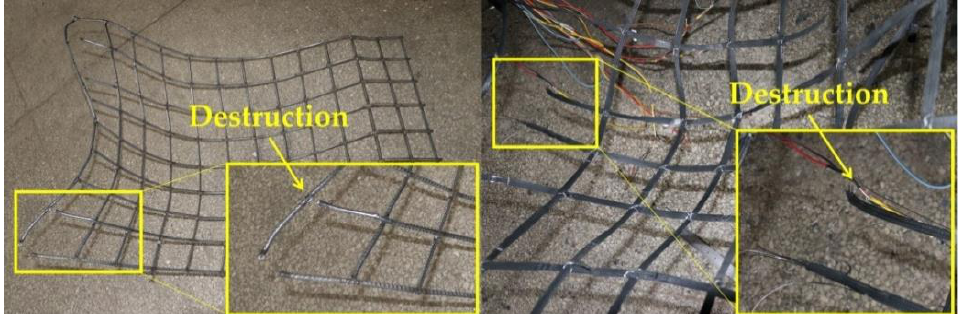
Figure 12. Diagram of mesh damage.